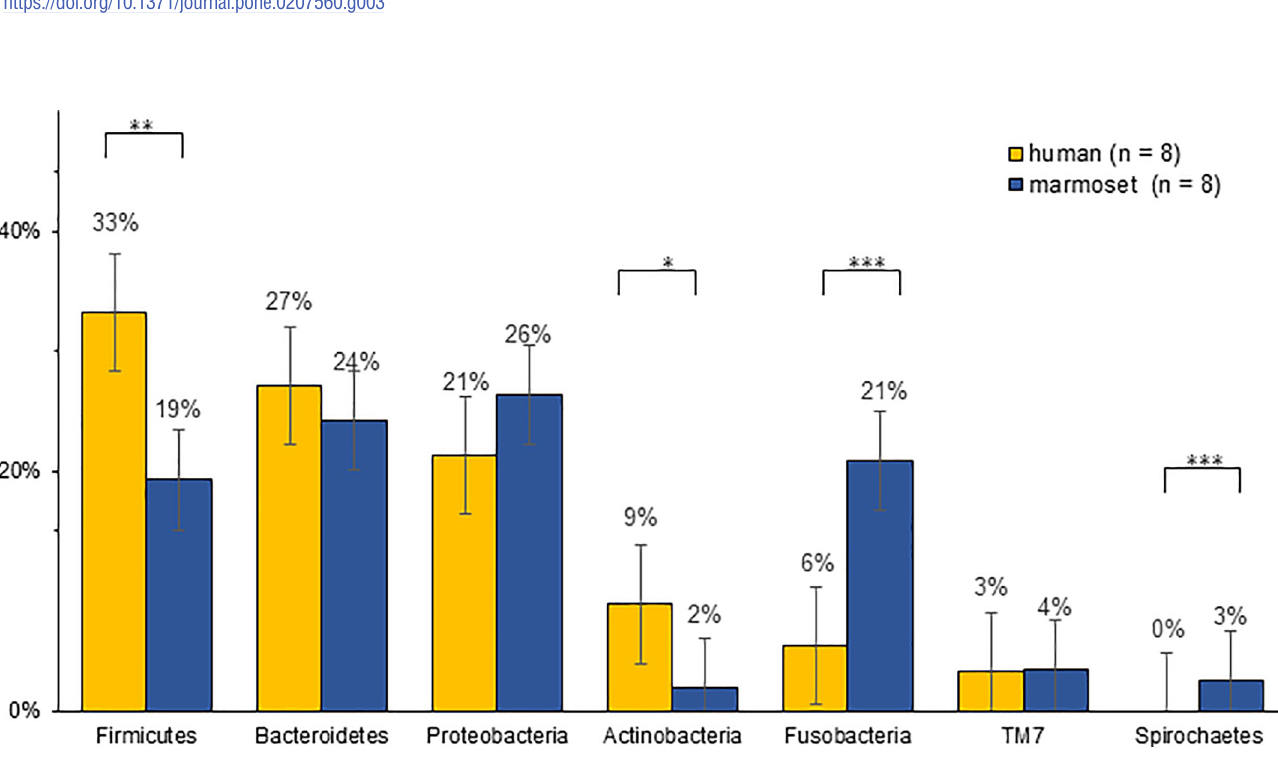
Fig 4. Relative abundance of bacteria (phylum level). � : p = 0.002, �� : p = 0.004, ��� : p < 0.0001.